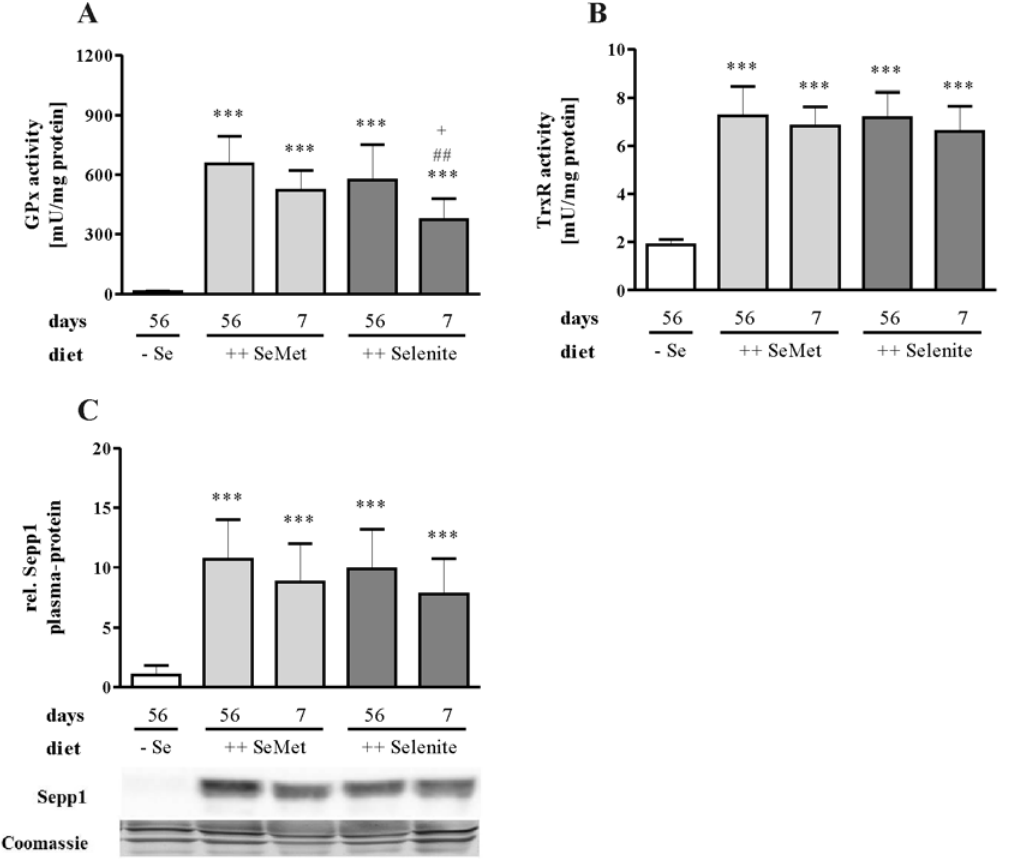
Figure 6. Systemic selenium status is not replete after short-term supplementation with selenite. Total ( A ) GPx and ( B ) TrxR activity was measured in homogenates of the liver. ( C ) Sepp1 protein levels in the plasma were detected by Western Blot analysis and normalized to Coomassie blue gel staining. Representative bands for each intervention group are shown. Data are depicted as the mean + SD. n = 12. Significant differences were calculated by one-way ANOVA and Bonferroni’s posttest. ** p < 0.01, *** p < 0.001 vs . − Se; ## p < 0.01 vs . ++ Selenite 56 days; + p < 0.05 vs . ++ SeMet 7